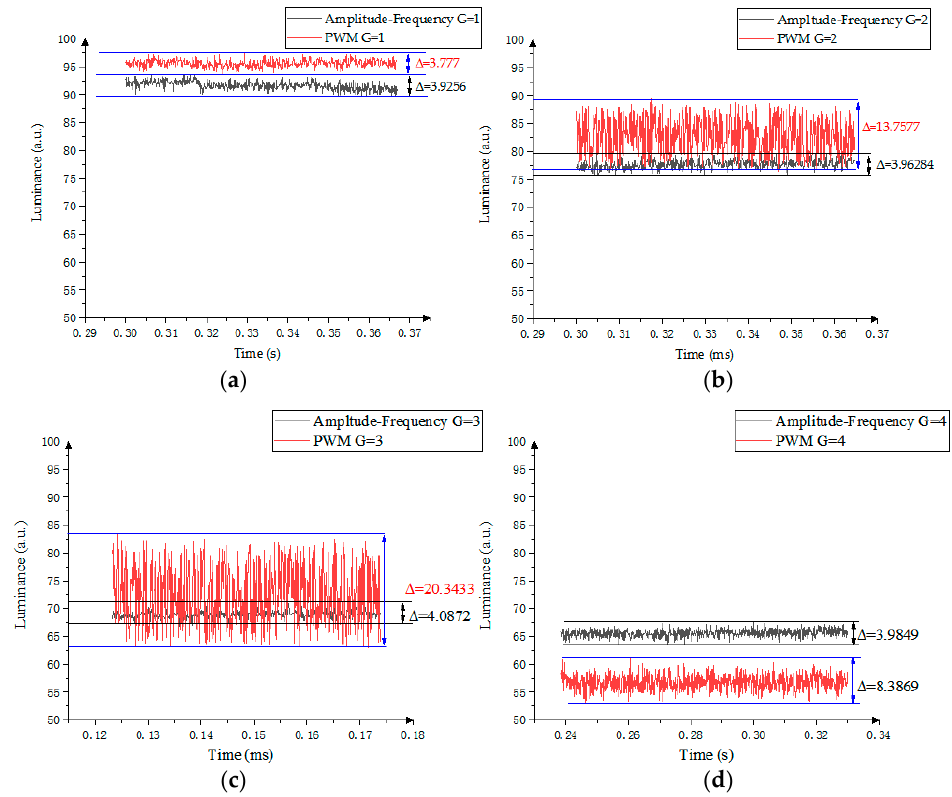
Figure 12. Gray-scale stability comparison between PWM modulation and amplitude–frequency mixed modulation. ( a ) First gray scale; ( b ) Second gray scale; ( c ) Third gray scale; ( d ) Fourth gray scale.